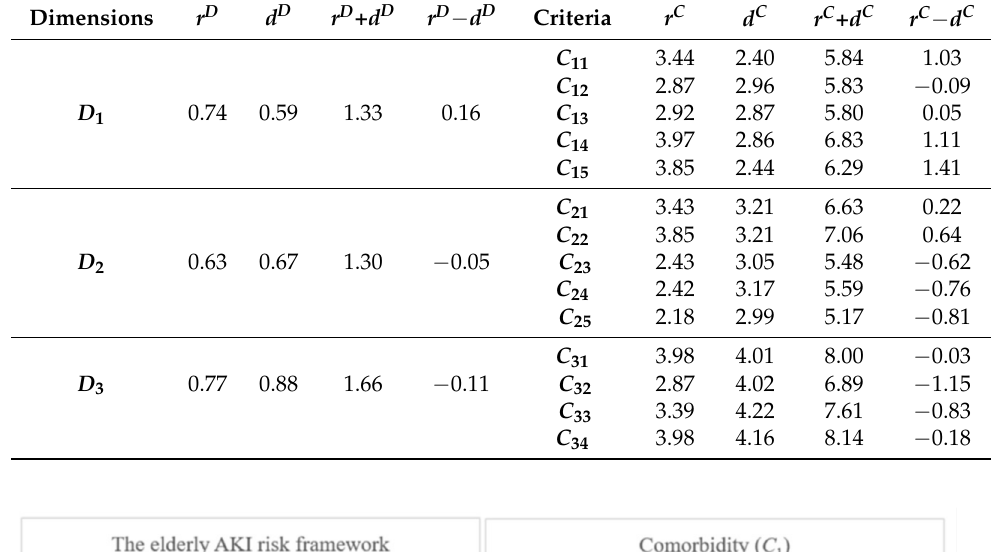
Table 4. Directional influence analytics from DEMATEL (Decision-Making Trial and Evaluation Laboratory) analysis.